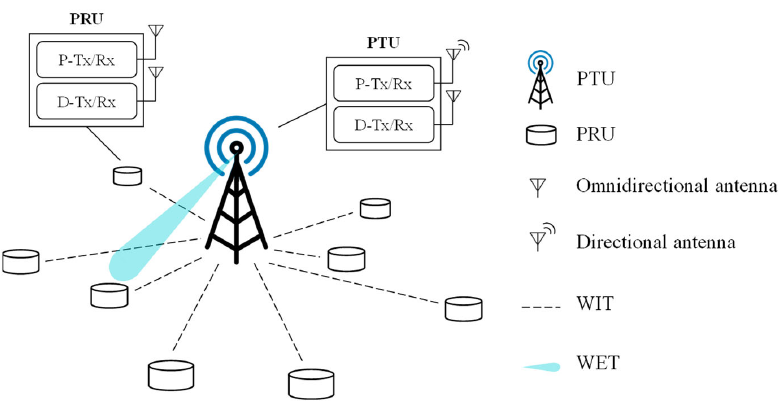
Figure 1. System architecture of REE ‐ MAC.